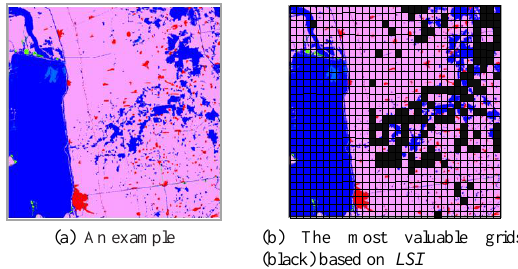
Figure 2. The overall design of landscape indices based sampling